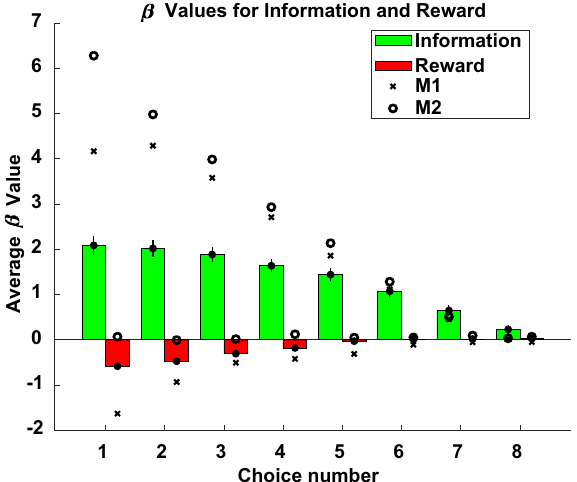
Figure 3. The influence of expected information and expected reward on choice number in trial for humans, M1, and M2. Each colored bar is the average beta across human participants, mean ± 1 s.e.m., error bars for often occluded by data points. X’s: M1; open circles: M2.